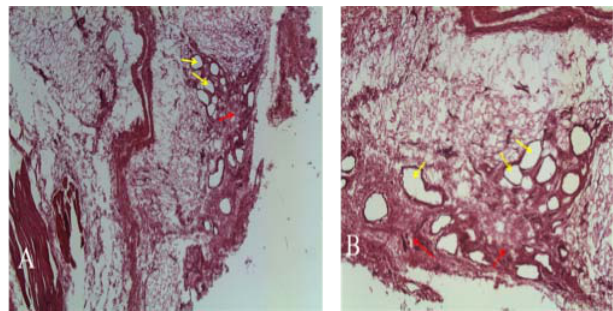
FIGURE 6 – Photomicrograph of adipose tissue after liposuction rabbit 5. Relation between inflammation and pathological changes; Chi-square test, p=0.035. Hematoxylin eosin, microcystis (yellow arrow), fibrosis (red arrow) A . 2x B . 4x.